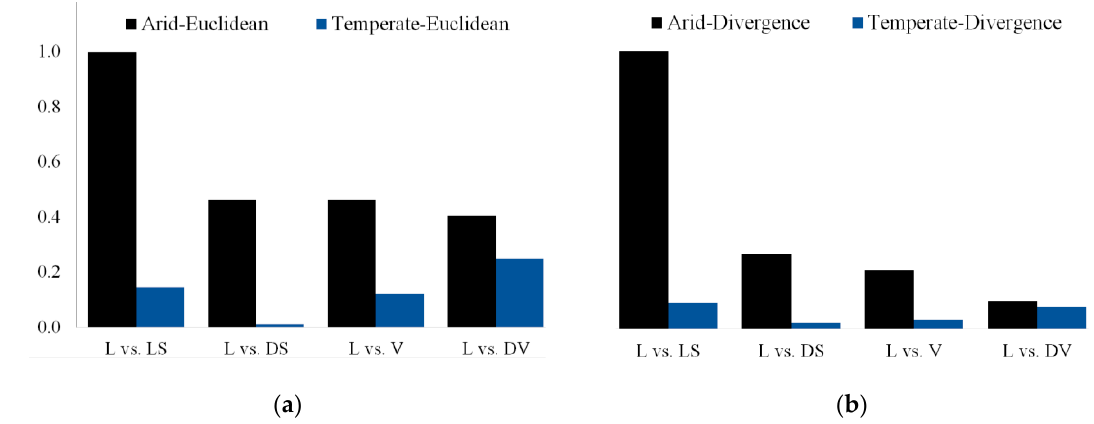
Figure 10. Histogram of the separability distance for the pilot areas representing the arid (black) and temperate (blue) periods: ( a ) normalized Euclidean distance, d E ; ( b ) normalized divergence, d D . Results show that, in the arid period, the densely vegetated soil class could be spec- trally confused with the hill lakes’ class ( d E = 0.40 and d D = 0.10); while in the temperate period, the dark soil class is the one that could be more easily misclassified with the hill